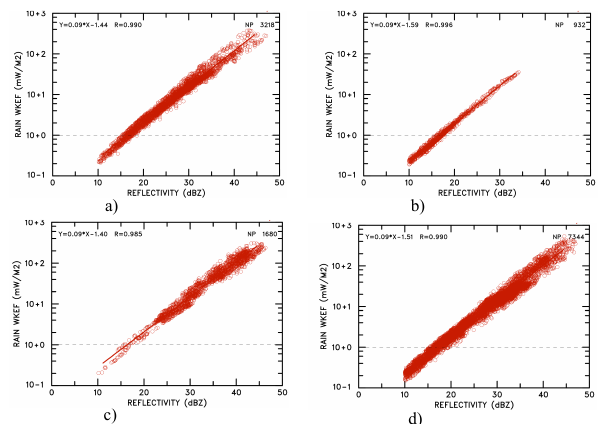
Fig. 11. Vertical kinetic energy flux VKEF, as a function of instan- taneous reflectivity factor for (a) 27 June 2009, (b) 19 August 2009, Figure 11 : Vertical Kinetic Energy Flux VKEF, as a function of instantaneous reflectivity 828 factor for a) 27 Jun. 2009, b) 19 Aug. 2009, c) 02 Feb. 2010 and d) 17 Mar. 2010. 829 (c) 2 February 2010 and (d) 17 March 830